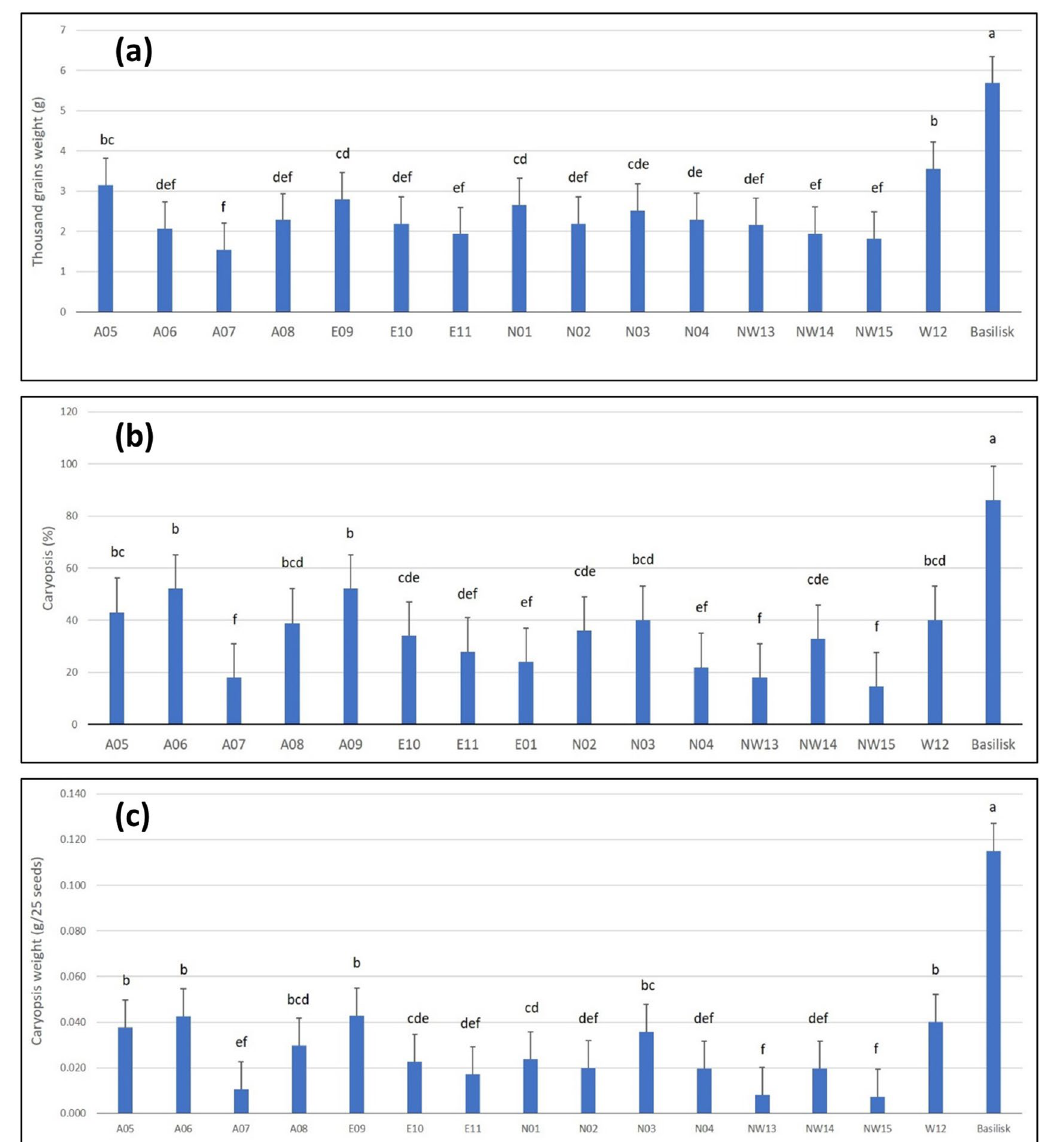
Figure 2. Quality attributes of 15 Urochloa seeds samples from Cameroon and seeds of Urochloa decumbens cv. Basilisk from Brazil, ( a ) thousand grain weight, ( b ) caryopsis percentage, and ( c ) caryopsis weight. Bars with different letters for each quality attribute are significantly different ( P < 0.0001). The error bars are standard errors